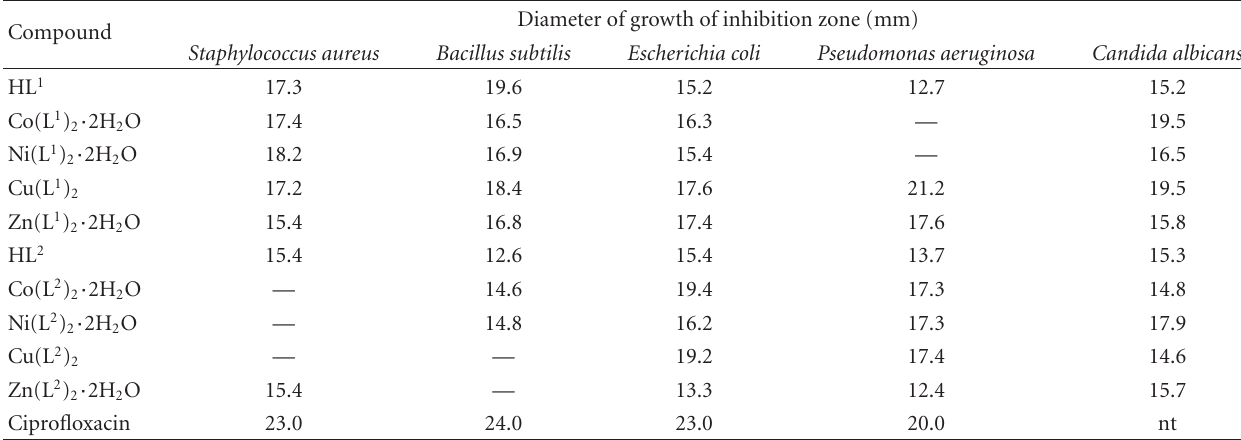
Table 5: Antimicrobial activity of the synthesized compounds.